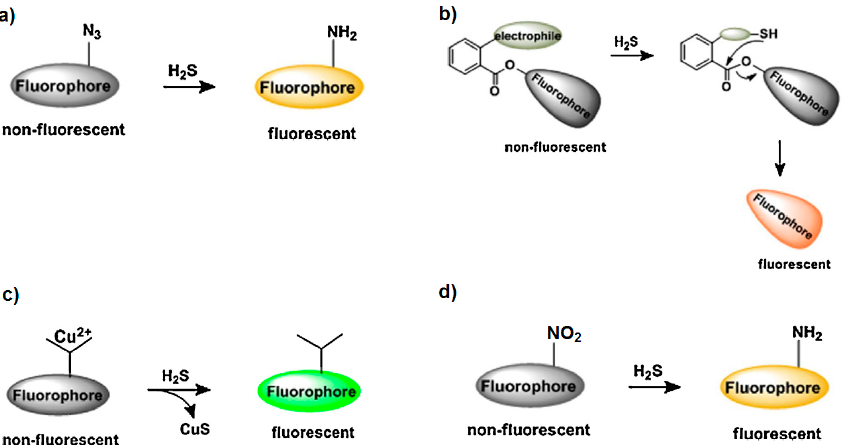
Figure 4. Reactions for the selective detection of H 2 S employing fluorescent probes. Reduction of azides into amines by H 2 S ( a ), nucleophilic addition of H 2 S to the probe resulting in a cyclization process that generates a fluorescent molecule ( b ), H 2 S mediates the precipitation of CuS ( c ), nitro to amine reduction ( d ). Adapted from [75], with permission from Elsevier.